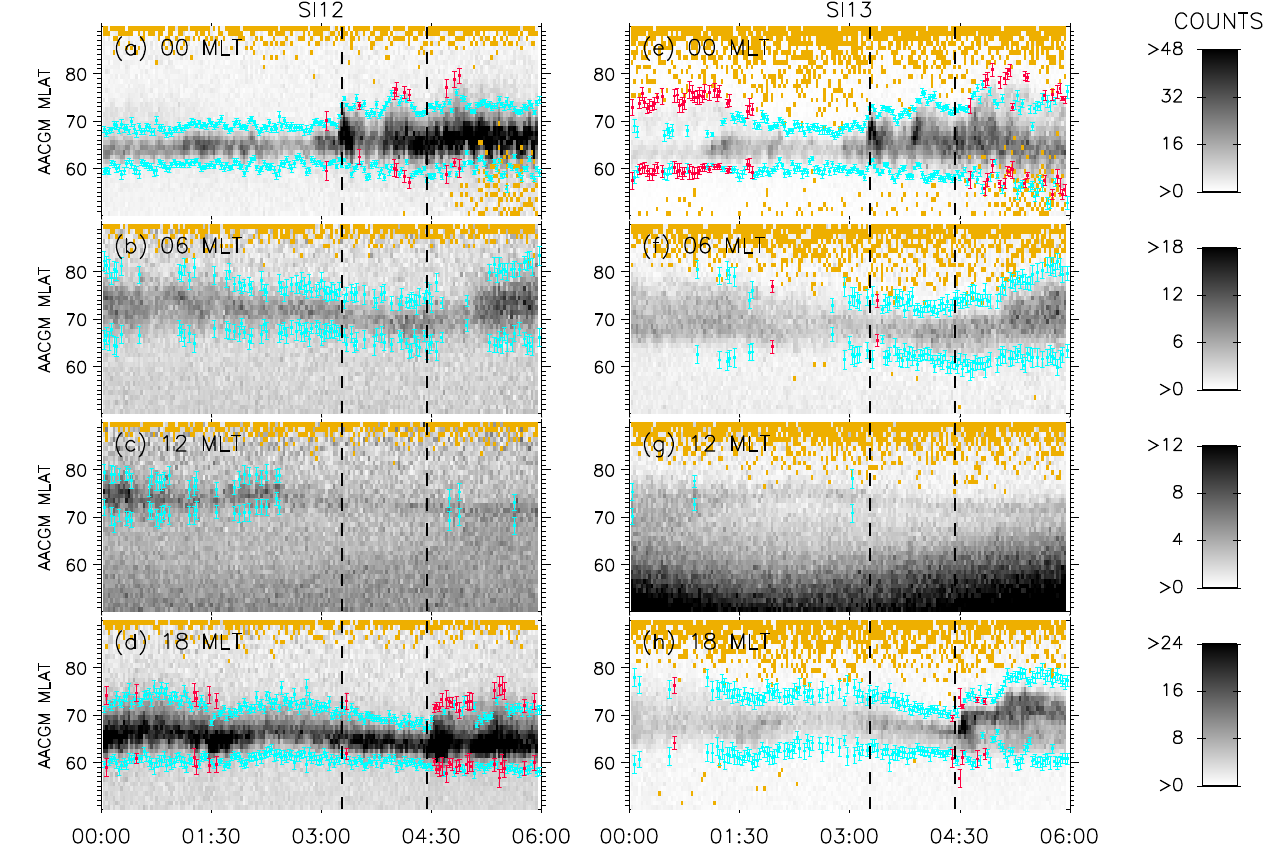
Fig. 3. Intensity counts recorded by the IMAGE FUV SI12 and SI13 sensors on the 1 February 2001 between 00:00 and 06:00UT. Count values above and below thresholds indicated in the intensity scales have been saturated. Not a Number (NaN) and zero count intensity values are shown in yellow. From top to bottom, the panels show the MLT sectors 00:00–01:00, 06:00–07:00, 12:00–13:00 and 18:00– 19:00, respectively. Panels (a) to (d) show auroral luminosity boundary locations derived according to the method detailed in this paper from SI12 images, with panels (e) to (h) showing the same derived from SI13 images. Blue squares denote poleward and equatorward luminosity boundaries determined from fits to a function with a single Gaussian component ( F s (λ) ), with blue error bars showing ± U λ on these boundaries. Red squares denote poleward and equatorward luminosity boundaries determined from fits to a function with a double Gaussian component ( F d (λ) ), with red error bars showing ± U λ on these boundaries. Vertical dashed black lines indicate times of substorm onset from the list outlined in Frey et al.